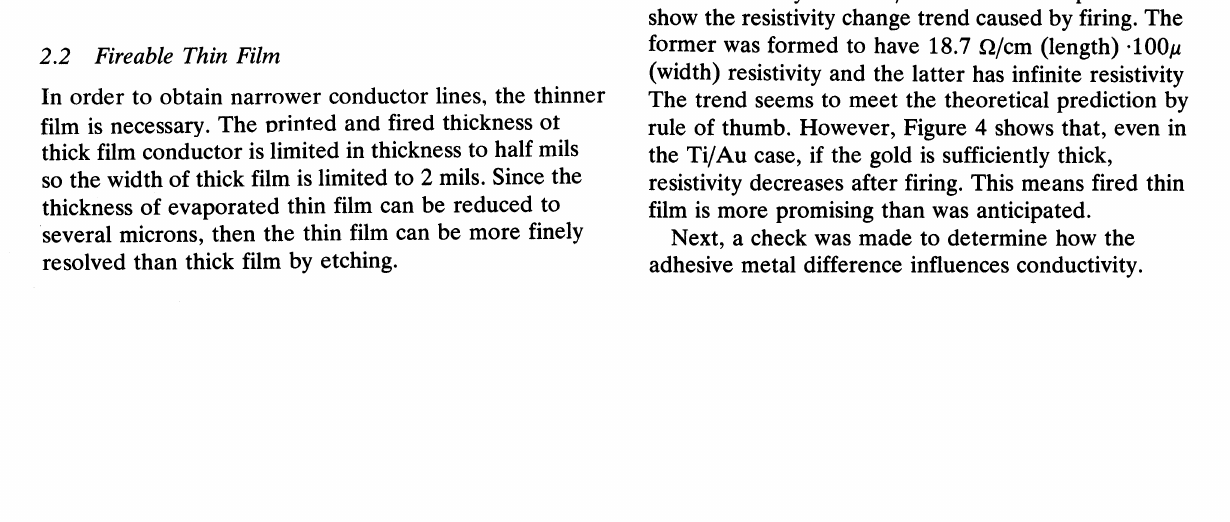
FIGURE 2 Etched thick film post